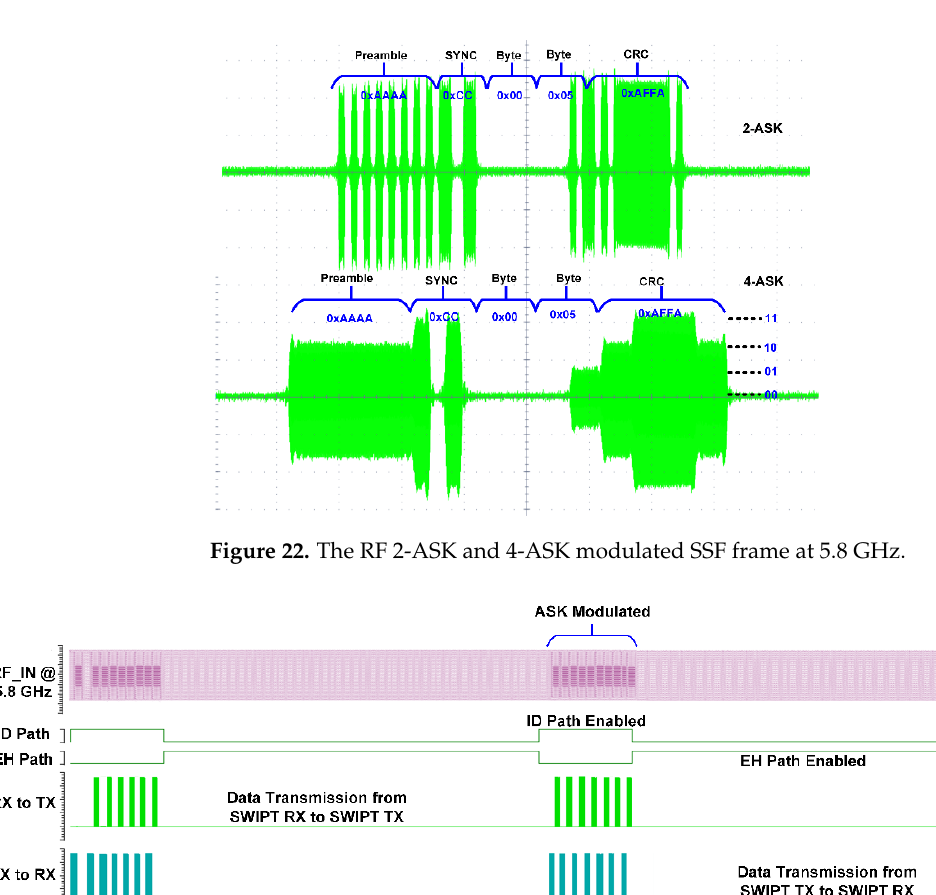
Figure 21. Charge and discharge voltage across the supercapacitor and MSOPL/MPL output sig- nals.